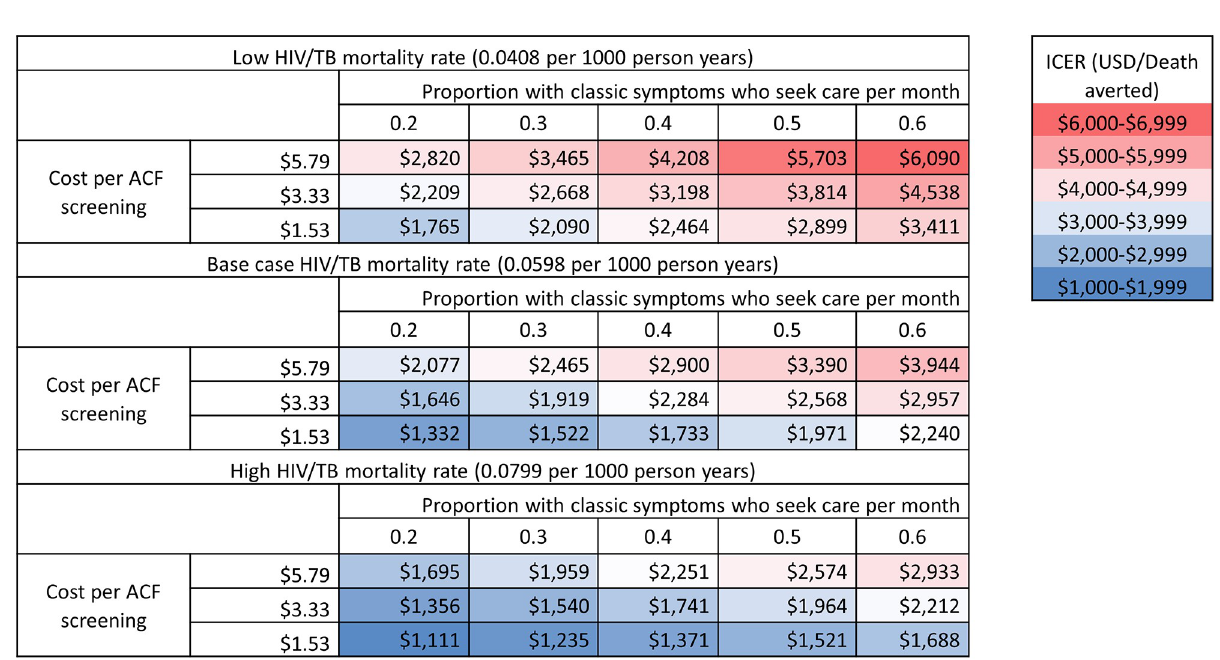
Fig 3. Three-way sensitivity analysis of the cost-effectiveness of active tuberculosis case finding over five years (2018–2022) in Zambia. This heat map displays the incremental cost-effectiveness of active TB case finding (ACF) compared to routine care, in units of cost per death averted. Each panel corresponds to a relative HIV/TB mortality rate (0.75 times base case, base case, 1.25 times of base case), with each column representing a different monthly probability of routine care-seeking behavior and each row depicting a different level of unit cost per ACF screening (as described as a measure of productivity level in ACF screening). The base case in our analysis had a HIV/TB mortality rate of 0.0598 per 1000 person years, 40% of individuals with classic symptoms seeking care to the clinic per month and cost per ACF screening of $3.33, resulting in an ICER of $2,284 per death averted.